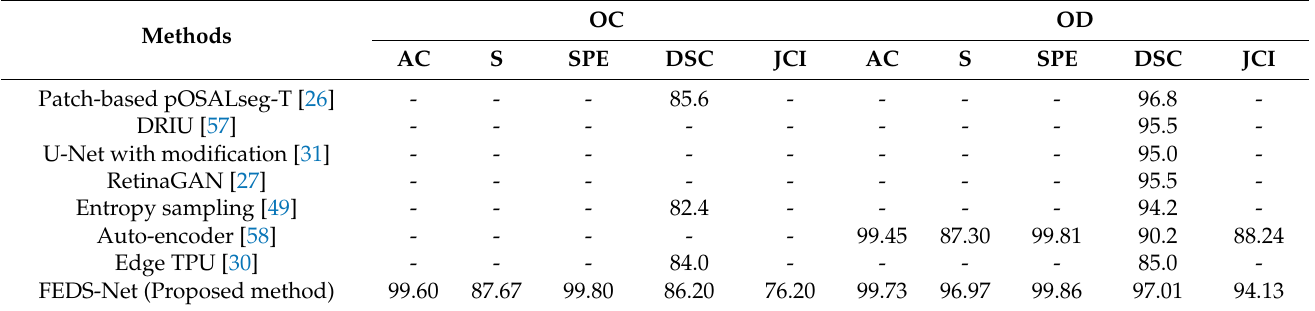
Table 3. Segmentation quantitative results comparison of FEDS-Net with state-of-the-art methods using Rim-One-r3 database. “-” indicates that no result is available (unit: %). (OC: optic